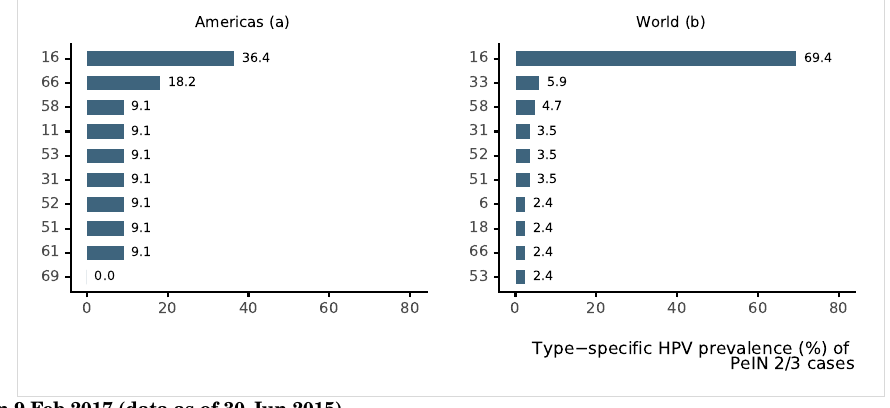
Figure 69: Comparison of the ten most frequent HPV types in PeIN 2/3 cases in Americas and the